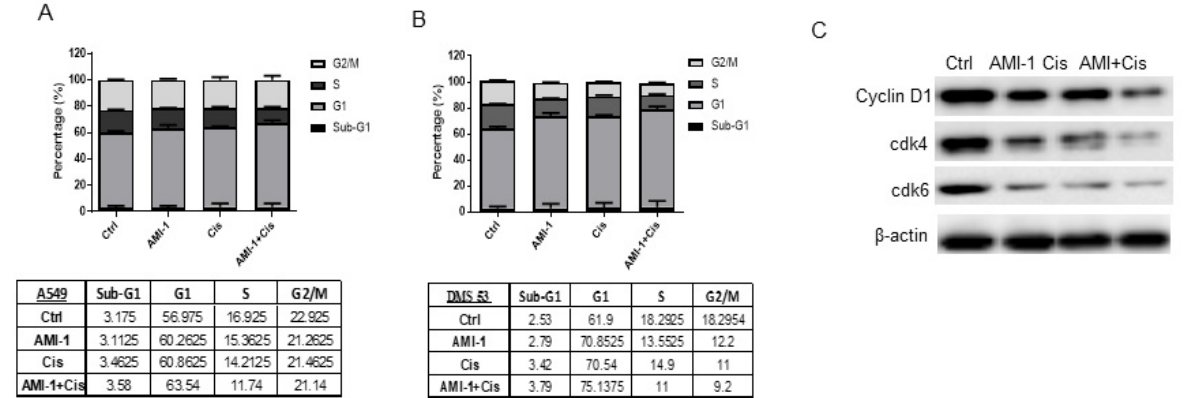
Figure 4. AMI-1 in combination with cisplatin induces G1 cell cycle arrest in lung cancer cells. The cell cycle progression in A549 and DMS 53 cells upon treatment with AMI-1; cisplatin or both for 48 h was measured by propidium iodide (PI) staining and analyzed using flow cytometry. ( A , B ) Bar graph showing the percentage of cells in sub-G1; G1; S; and G2/M representative of flow cytometric analysis of A549 cells ( A ) and DMS 53 cells ( B ) treated with AMI-1 and cisplatin alone or in combination with cisplatin indicating the different phases of the cell cycle. Percentage of cells occupying sub-G1; G1; S; and G2/M phases of the cell cycle were determined using the cell cycle platform of FlowJo software. Data here are representative of two independent experiments. Tables represent values of individual cell populations in each cell cycle phase. ( C ) Representative Western blot of cyclin D1; cdk4; and cdk6 levels in A549 cells after administration of AMI-1 and/or cisplatin. ß-actin was used as the loading control.